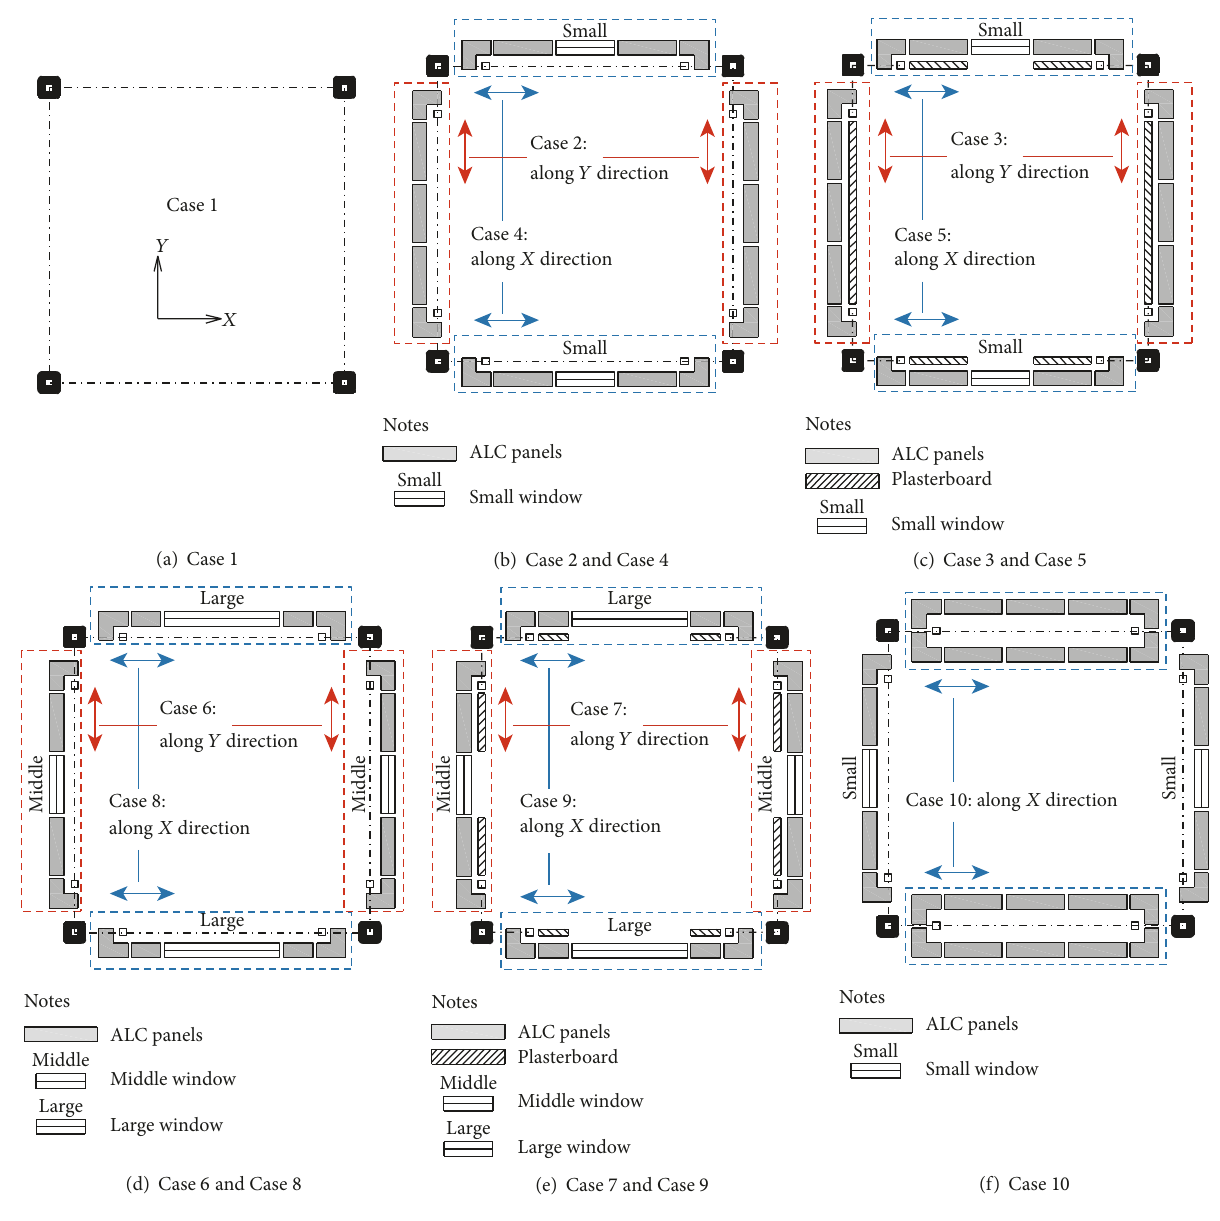
Figure 3: Layout of test